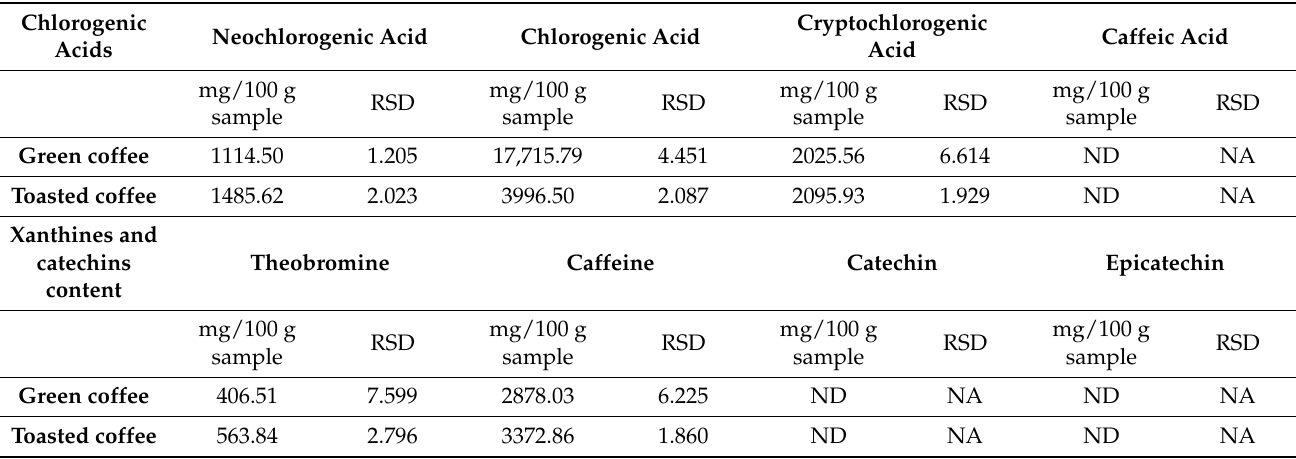
Table 1. The chlorogenic acids, xanthines, and catechins in green and toasted coffee extracts (GC, TC) by HPLC-DAD. All analyzes were performed on three independent samples. ND, not detectable. NA, not applicable. RSD, relative standard deviation.